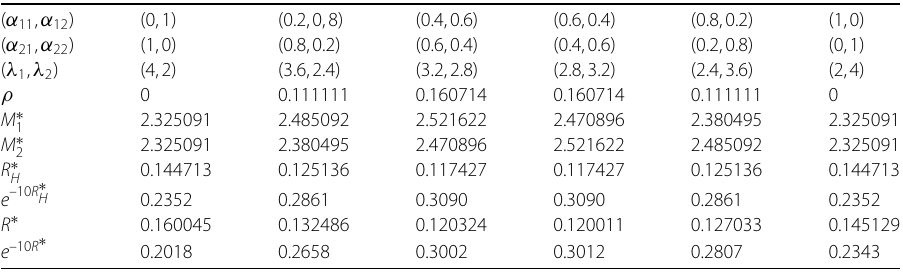
Table 3 Comparison of Lundberg exponent: Pareto distribution. ( θ 1 , θ R of Lundberg exponent and upper bound of ruin probability with different dependence parameters for Hu’s model and our model